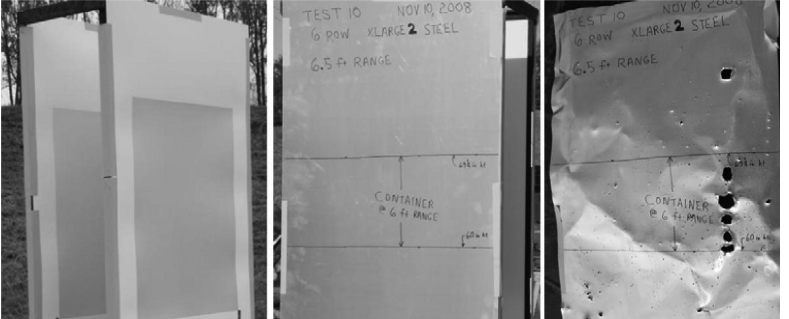
Fig. 5. Velocity screens and witness